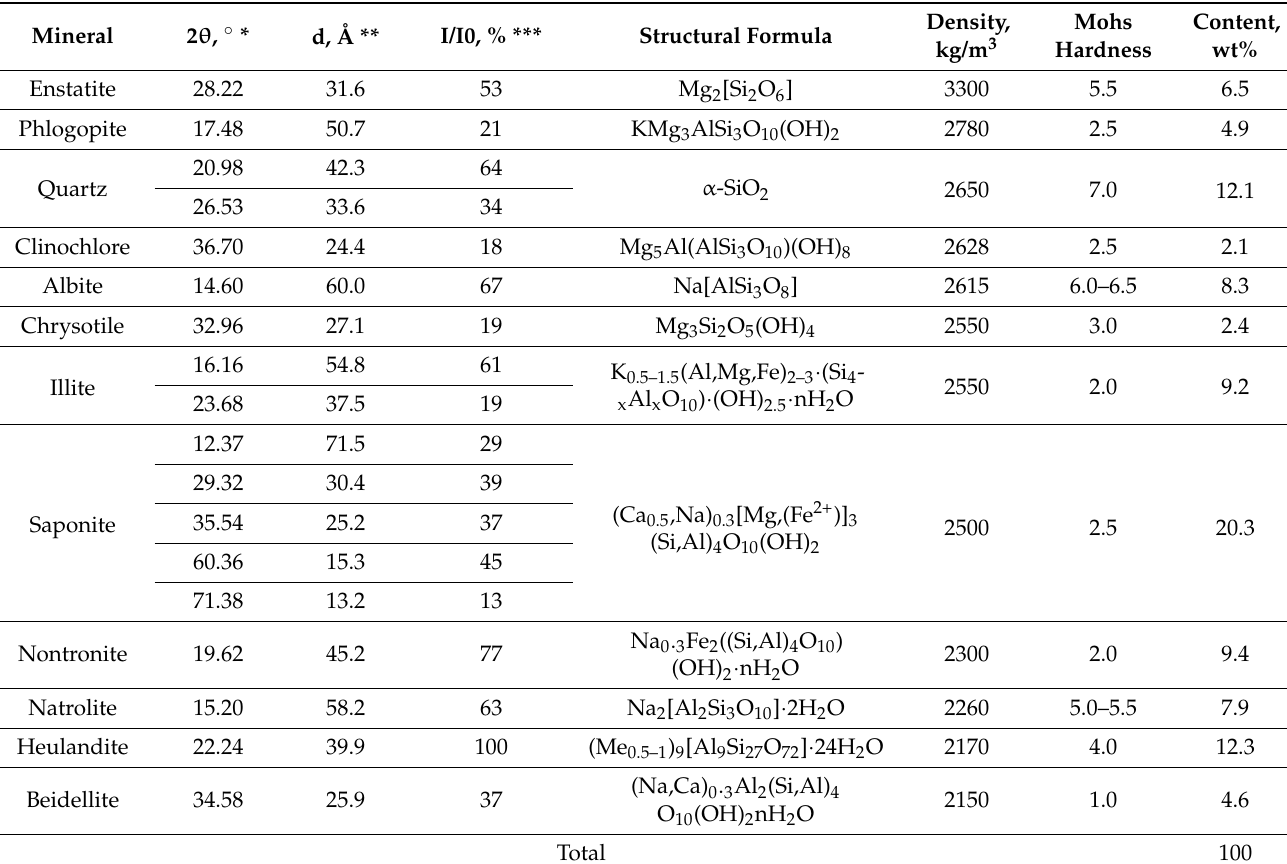
Table 1. Mineral composition of saponite diamond-bearing ore from the Arkhangelsk pipe. Mineral Structural